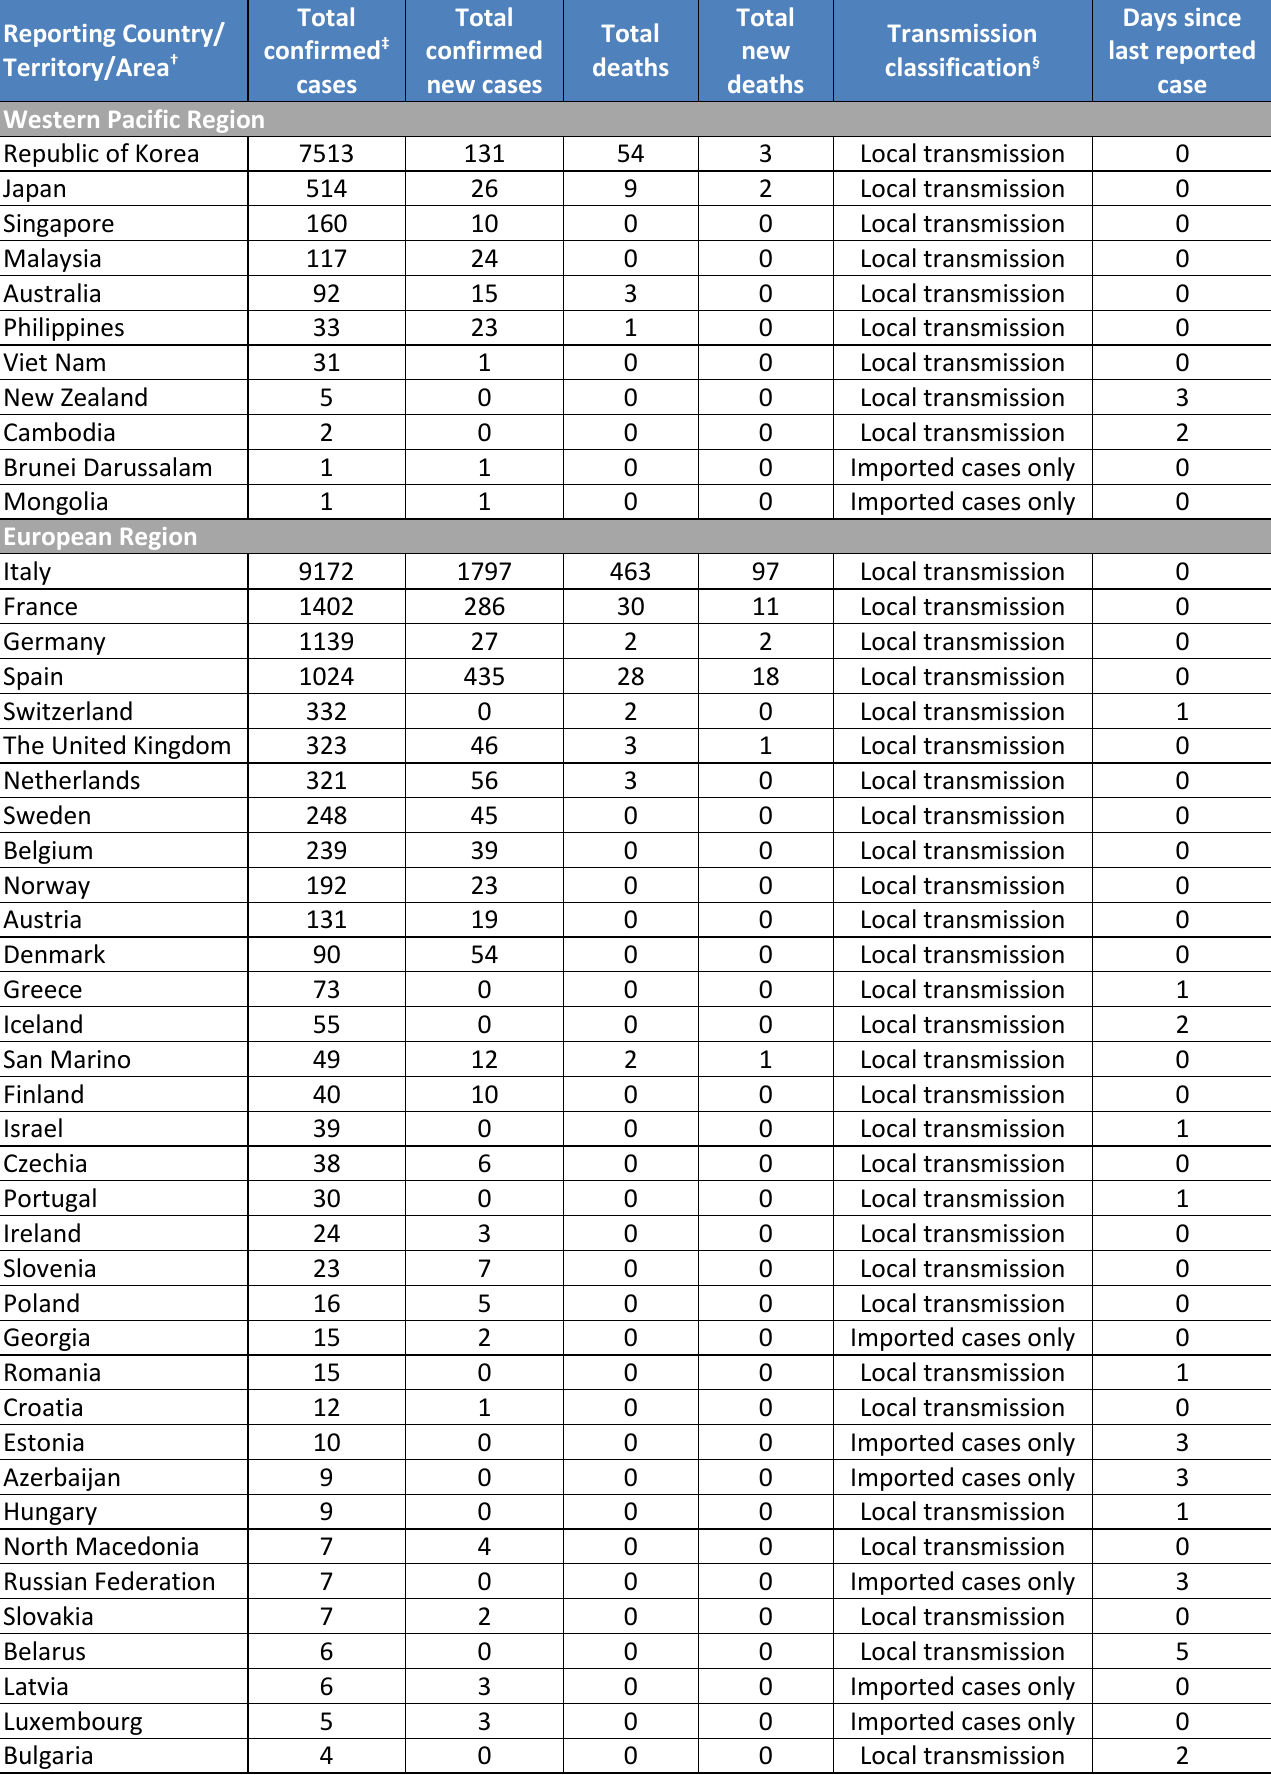
Table 2. Countries, territories or areas outside China with reported laboratory-confirmed COVID-19 cases